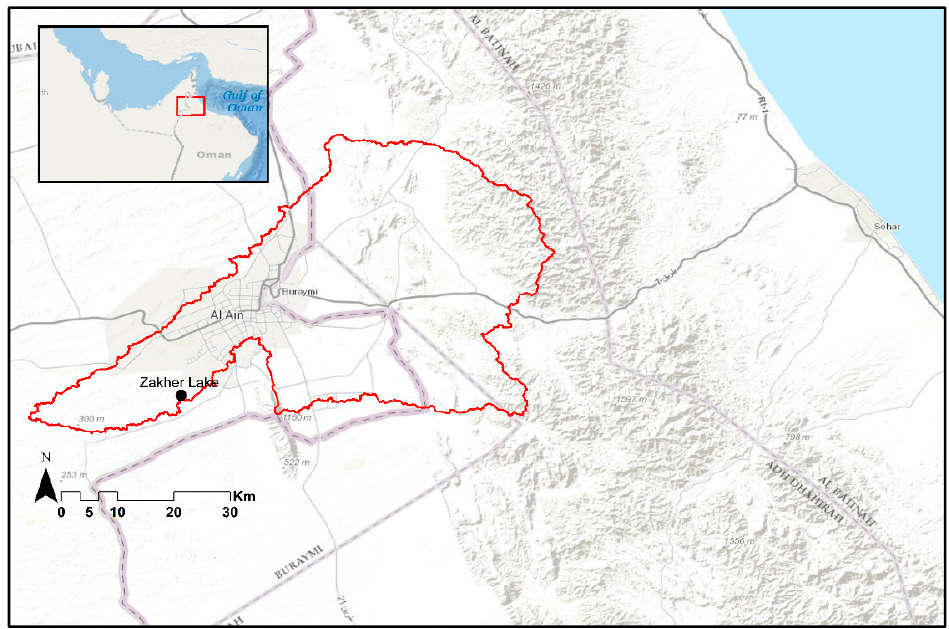
Figure 1. The city of Al Ain and its location on the Eastern United Arab Emirates (UAE) borders with Oman, and the red line shows the watershed boundary.